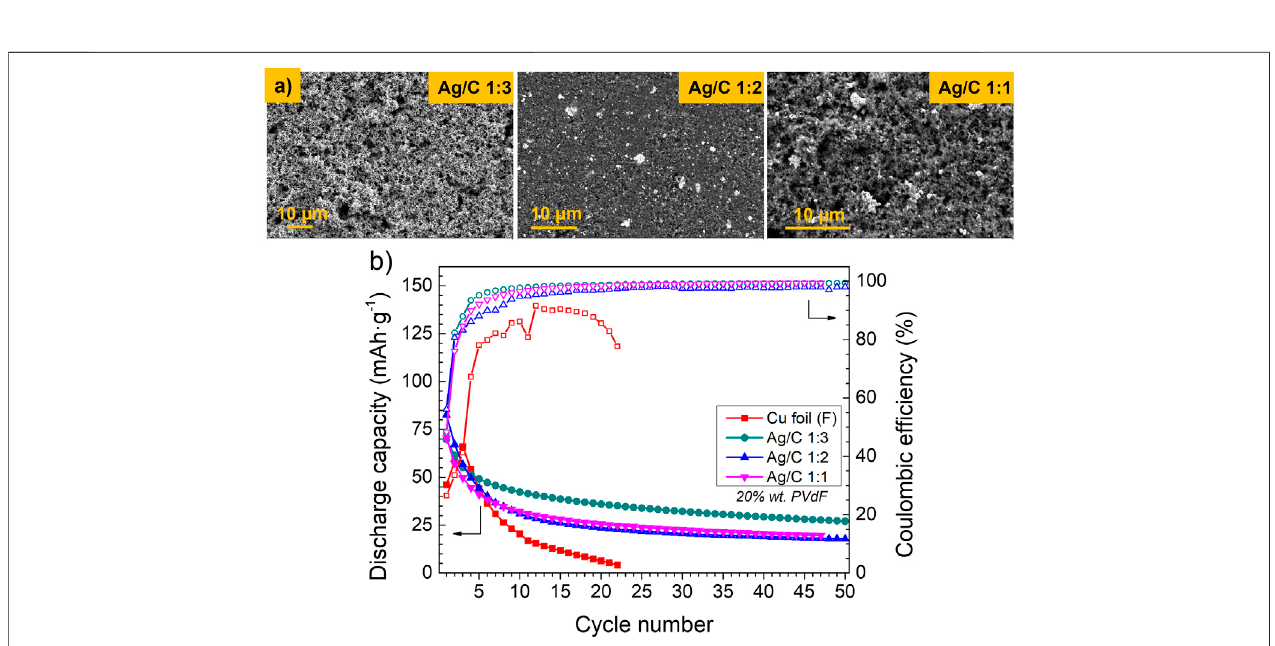
FIGURE 2 | (A) FE-SEM micrographs of Cu foil and Ag/C coatings with different Ag:C ratios on Cu foil as the anode current collector. (B) Discharge capacity and Coulombic ef fi ciency of single-layer pouch cells using anode current collectors coated by different Ag/C nanocomposite layers. Cycling conditions: 60 ° C, 1 N m, DoD 100%, 2.5 – 3.8 V, 0.1C – 0.1C, and charge cut off current